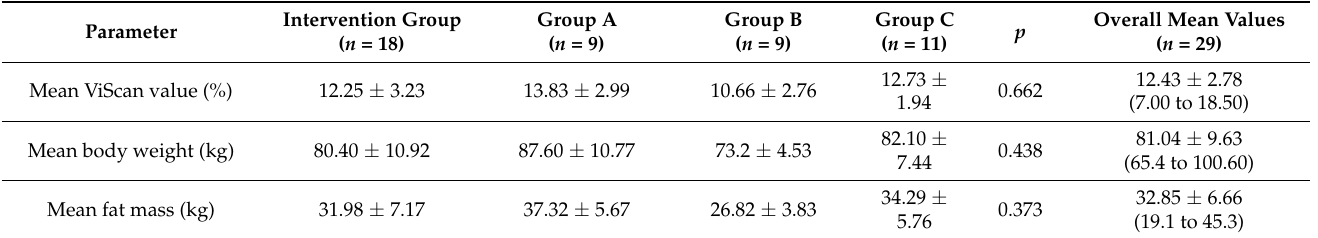
Table 3. Mean anthropometric parameter values ± standard deviation at baseline visit. p : statistical difference between intervention and placebo group.